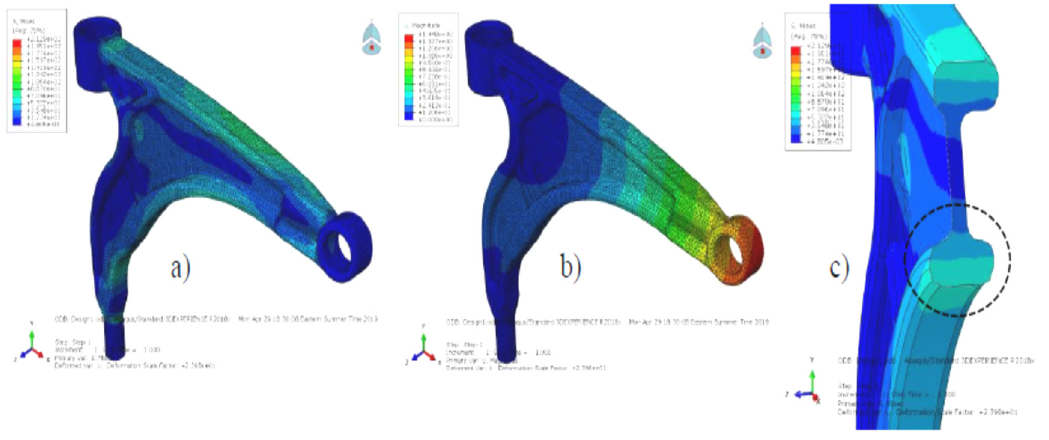
Figure 7. Finite elements analysis (FEA) of inclined web design. ( a ) von Mises stress plot, ( b ) total displacement plot, ( c ) cross-sectional stress distribution.